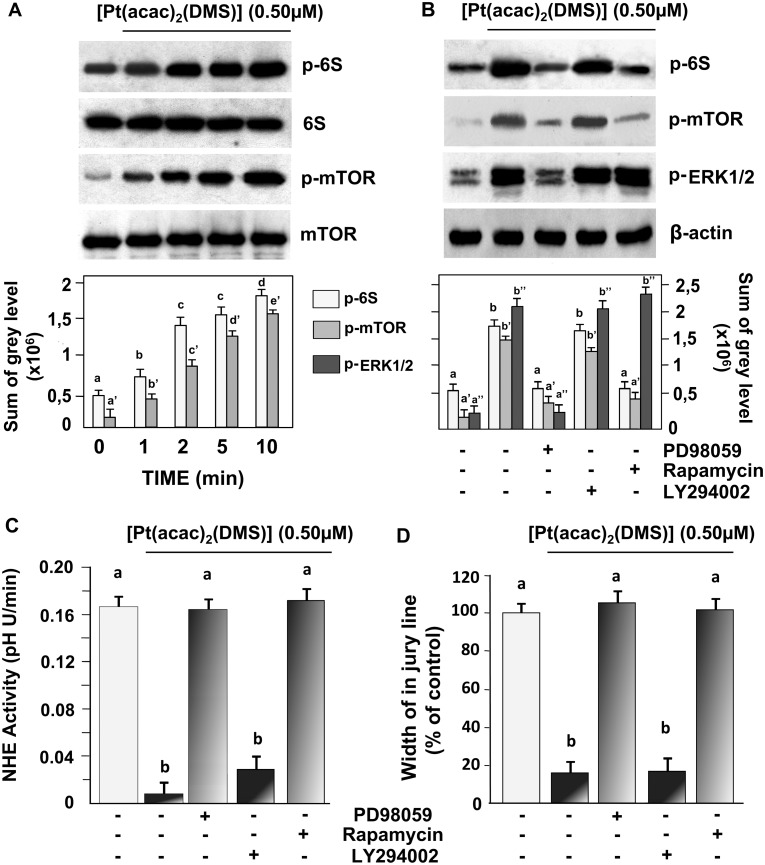
Role of p70 S6 Kinase in [Pt(acac)2(DMS)] inhibition of SH-SY5Y cell migration.(A) SH-SY5Y cells were incubated or not with 0.50 µM [Pt(acac)2(DMS)] for the indicated times. Cell lysates were analysed by western blotting with anti- unphosphorylated (6S and mTOR) and phosphorylated (p-6S and p-mTOR) 6S and mTOR antibodies. (B, C and D) SH-SY5Y cells were preincubated with 0.50 µM of [Pt(acac)2(DMS)] in absence or in presence of PD98056, rapamycin or LY294002. (B) Cell lysates were analysed by western blotting with anti-phosphorylated 6S, mTOR and ERK1/2 antibodies. Control loadings are shown by β-actin, representative immunoblots of four experiments are depicted and results from densitometry are expressed as mean ± SD (n = 4) of sum of the gray level values. (C) NHE activities, after acute exposure to an NH4Cl acid load, were measured and cell migration was examined using wound closure assay. Migration rate of wound closure were assessed by measuring the distance between wound edges in at least eight randomly chosen regions of three different experiments (average ± SD) normalized to 100% wound closure for control cells. Representative immunoblots of four experiments are depicted and results from densitometry are expressed as mean ± SD (n = 4) of sum of the gray level values. The data are means ± S.D. obtained from 4 different experiments. (A–D) P<0.0001 by one-way ANOVA (n = 4); values with shared letters are not significantly different according to Bonferroni/Dunn post hoc tests.